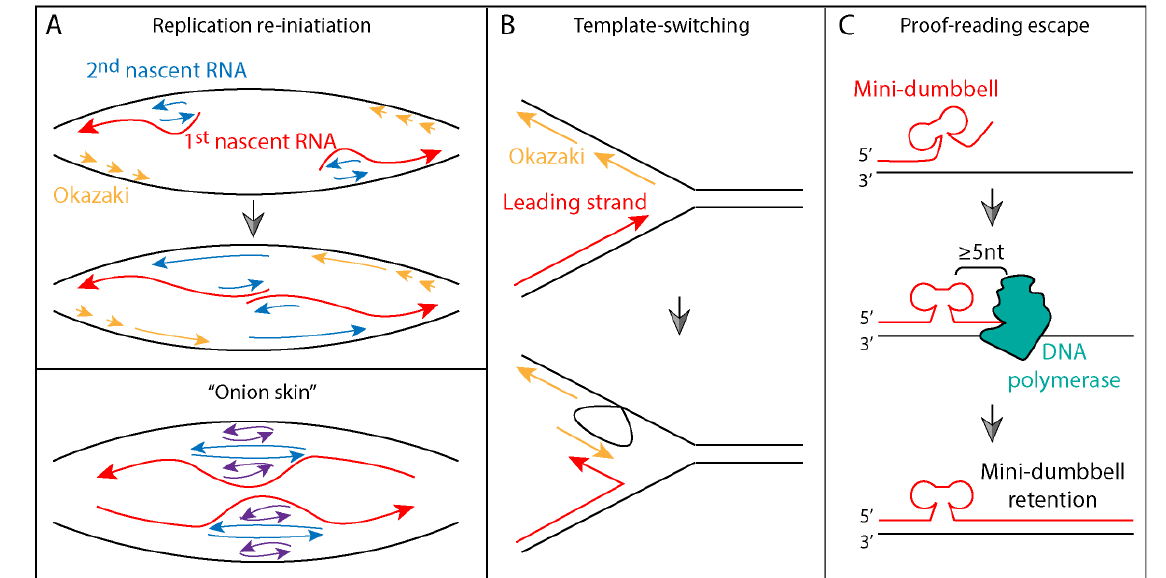
Figure 2. Three proposed models for SCA10 repeat expansion. ( A ) In the replication re-initiation model, multiple DNA unwinding events occur simultaneously at the ATTCT DUE. The branched DNA or “onion skin” layers, formed between nascent strands or between nascent and template strands, undergo recombination and end joining to give rise to large scale expansions. They may also undergo strand breakage associated with replication fork collapse to cause repeat contraction.